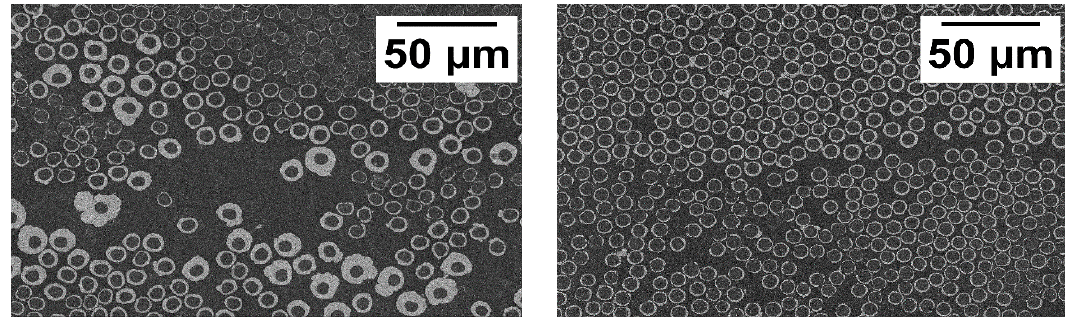
Figure 3. SEM cross-section images of the copper-coated fiber ( a ) with inhomogenous coating, ( b ) with detached coating.